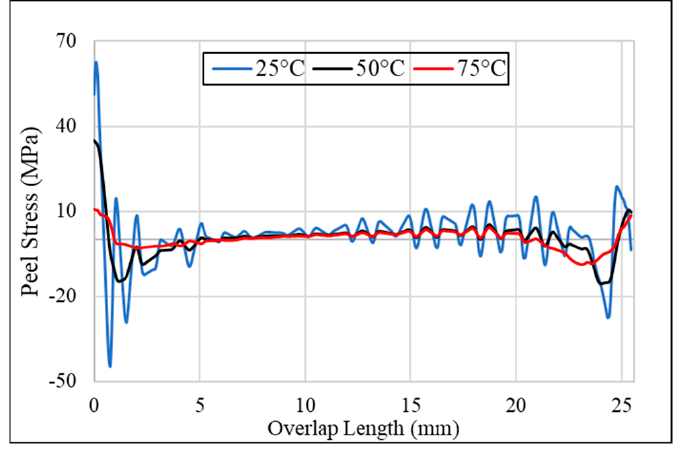
Figure 9. Peel stress distribution at location D of SLJ with neat adhesive at different temperatures.